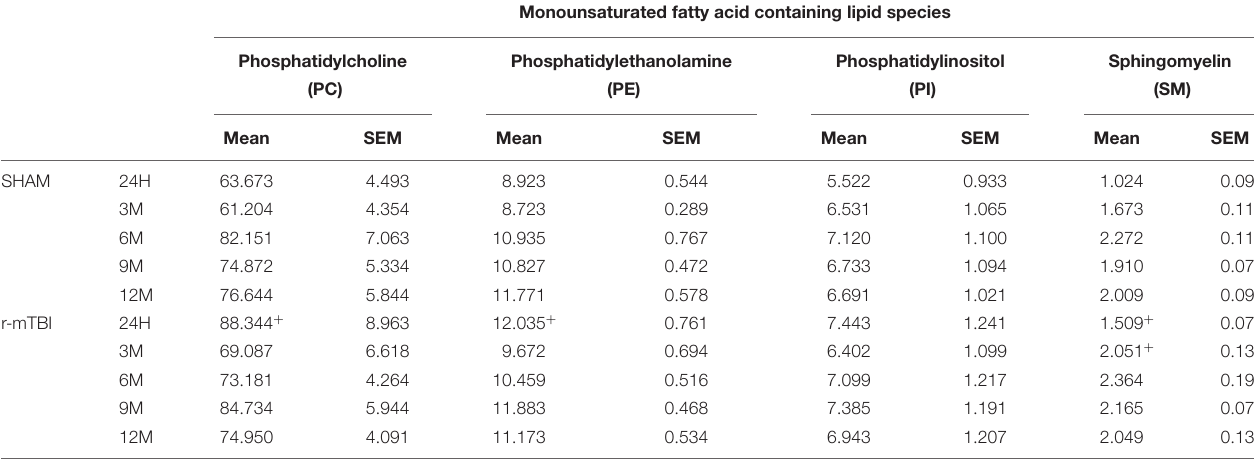
TABLE 4 | Monounsaturated fatty acid containing phospholipid species in the cortex of repetitive mTBI hTau